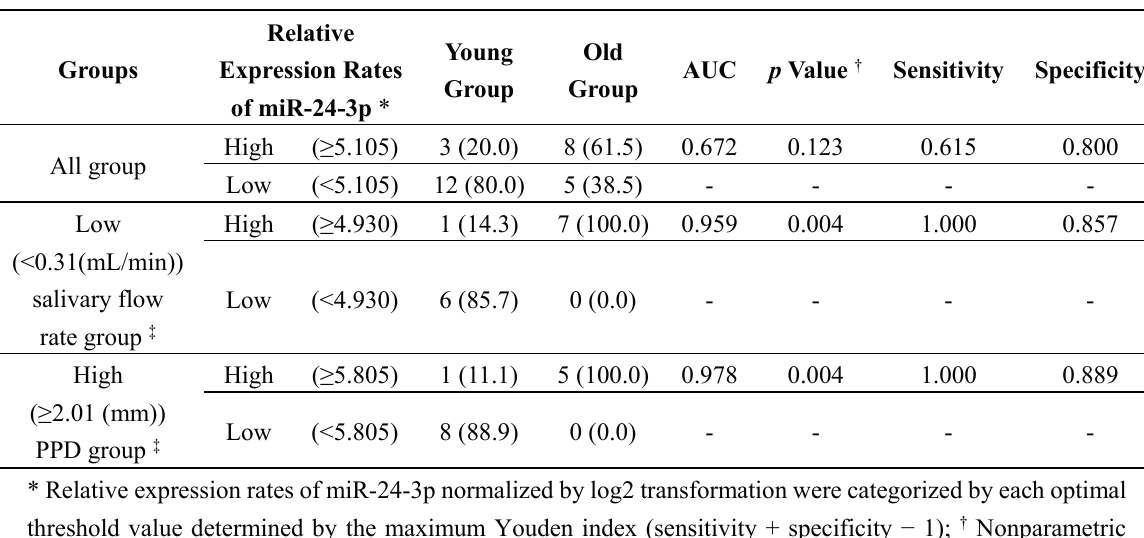
Figure 2. Receiver operating characteristic (ROC) curves for detection of old group in all participants ( A ); participants with low salivary flow rate ( B ); and participants with high probing pocket depth ( C ). The circle plots represent the sensitivity and specificity with optimal threshold value determined by the maximum Youden index (sensitivity + specificity − 1). Table 5. Receiver operating characteristic curve analysis using expression rates of miR-24-3p to detect for old